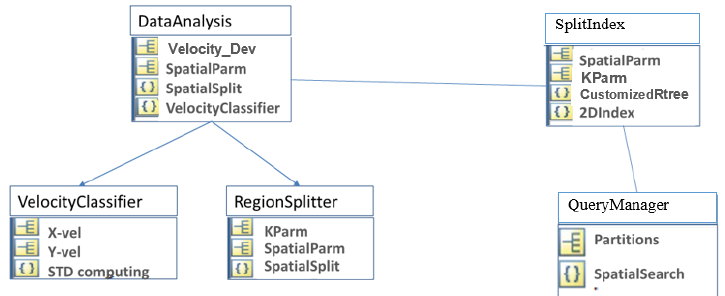
Figure 3. Conception of the indexing